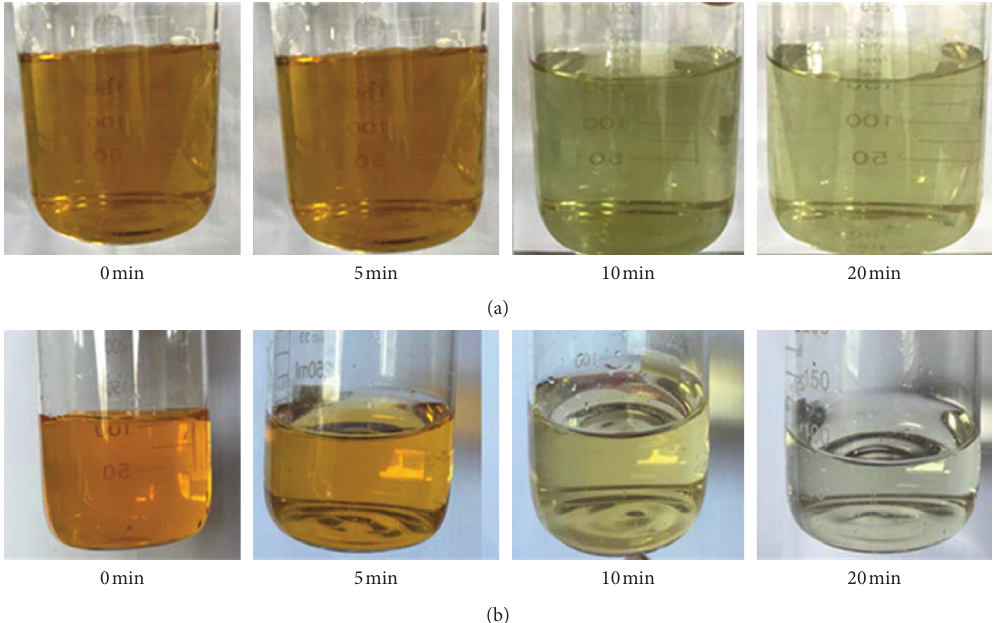
Figure 25: Decolorization of methyl orange from 0 to 20 minutes: (a) when 5000ppm PF AgNPs and (b) 333ppm PF AgNPs were added.